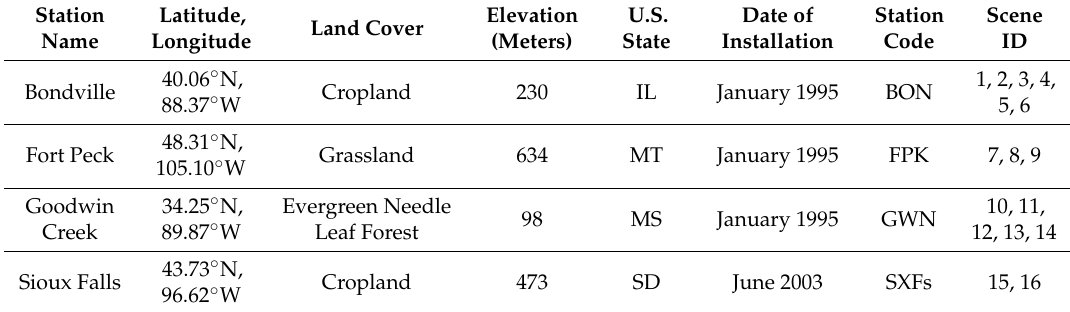
Table 3. SURFRAD Stations Information [19].